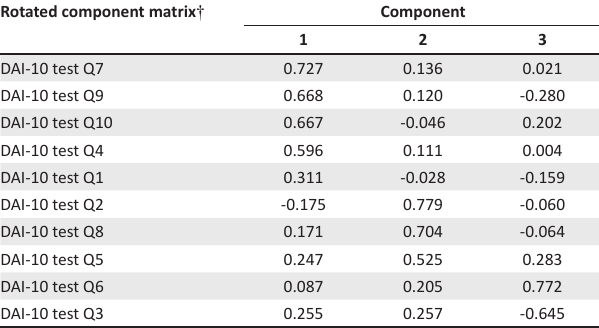
TABLE 4: Rotated component matrix of 10-item Drug Attitude Inventory. Rotated component matrix